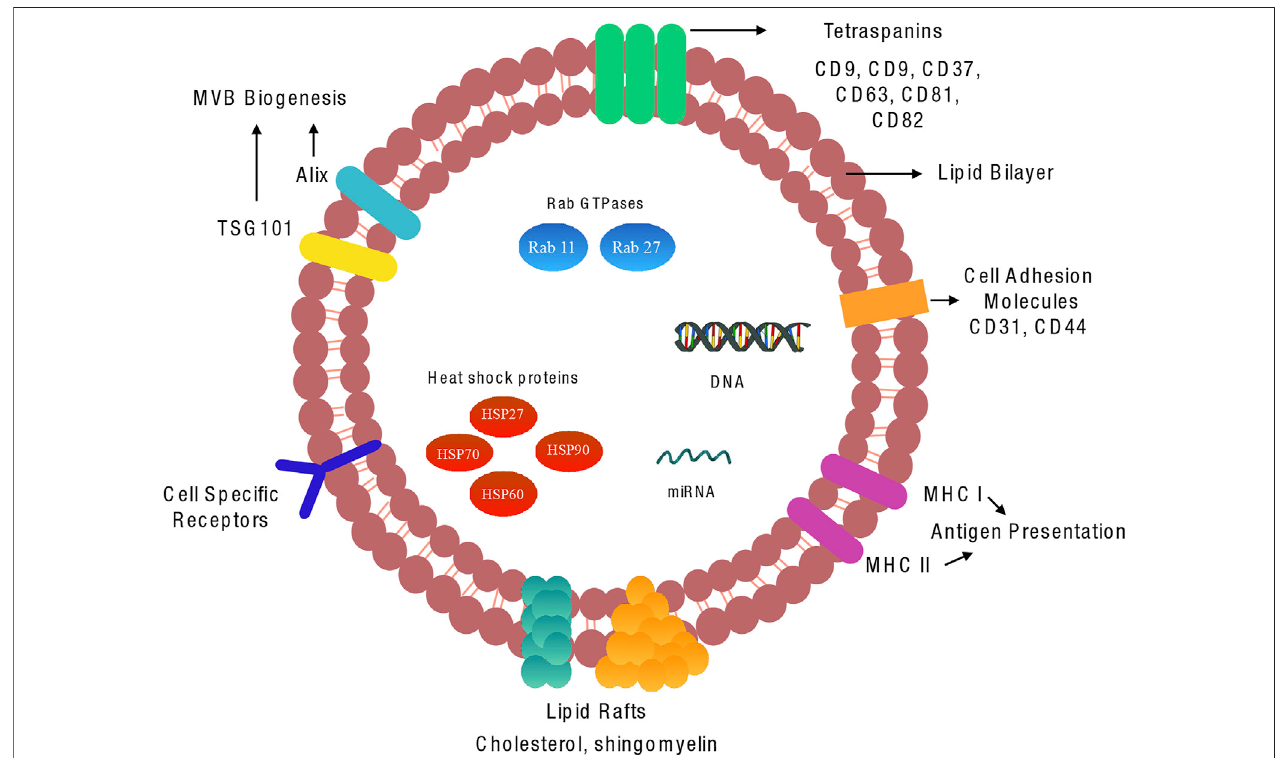
FIGURE 2 | Molecular components of vascular exosome: Exosomes are composed of a plasma membrane-derived phospholipid bilayer containing cytosol componentsfromthecelloforigin.Thecompositionoftheexosomesisdependentonthecelltypeoforigin,thestateofhealthofthesourcecell,andextracellularstimuli. There are various proteins, lipids, and miRNAs that are common to the majority of exosomes.